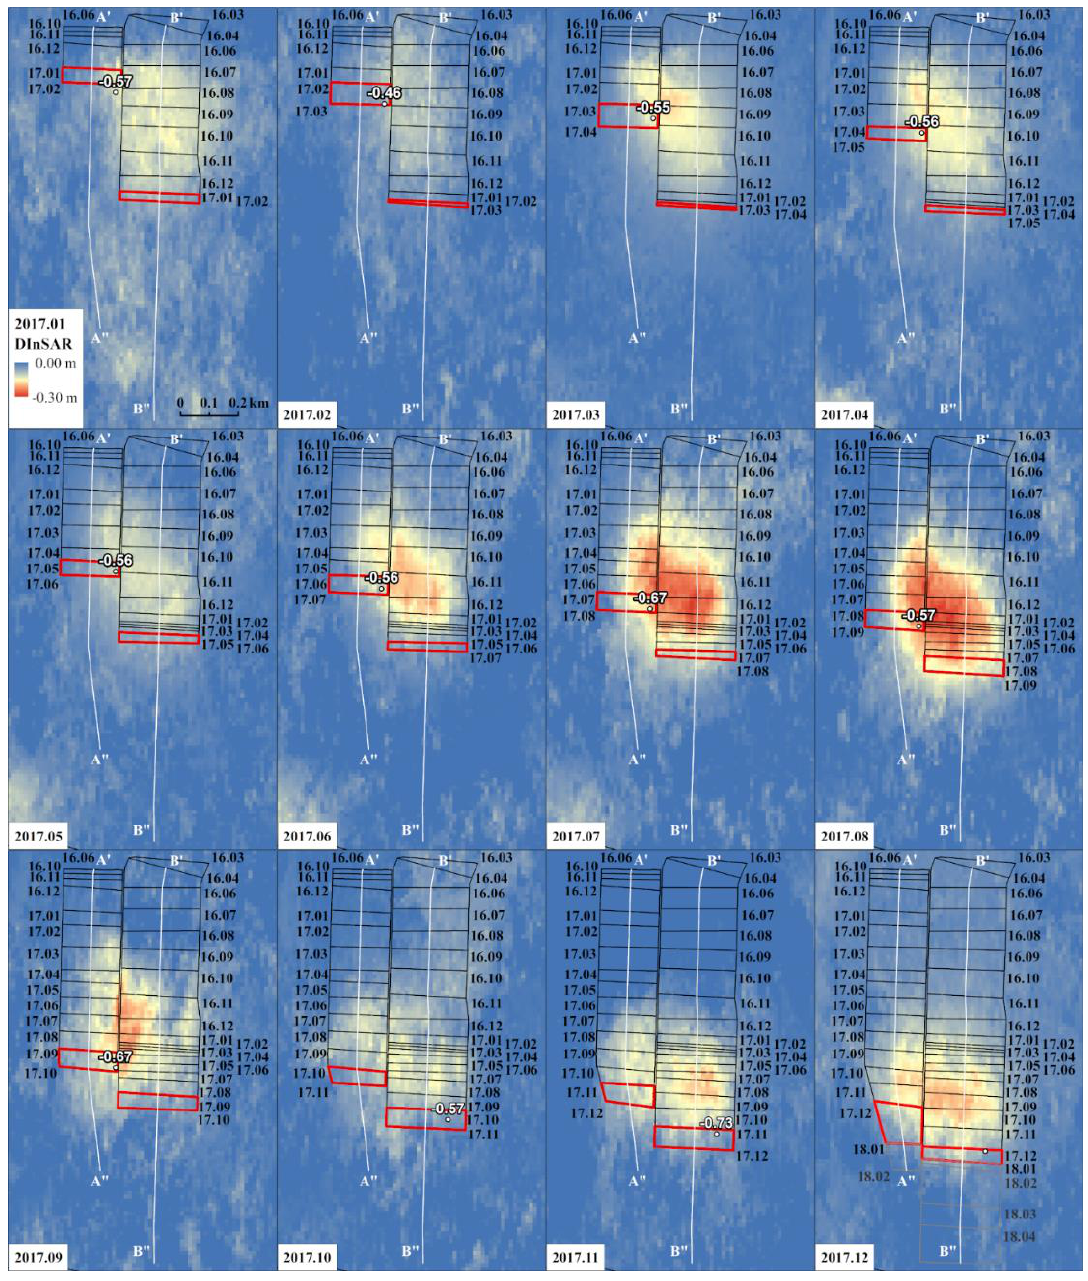
Figure 12. Monthly advancement of coal extraction presented by the red panels and main subsidence presented by images according to the DInSAR measurements. Profiles along the line A’A” are shown in Figure 14 and along the line B’B” in Figure 16.